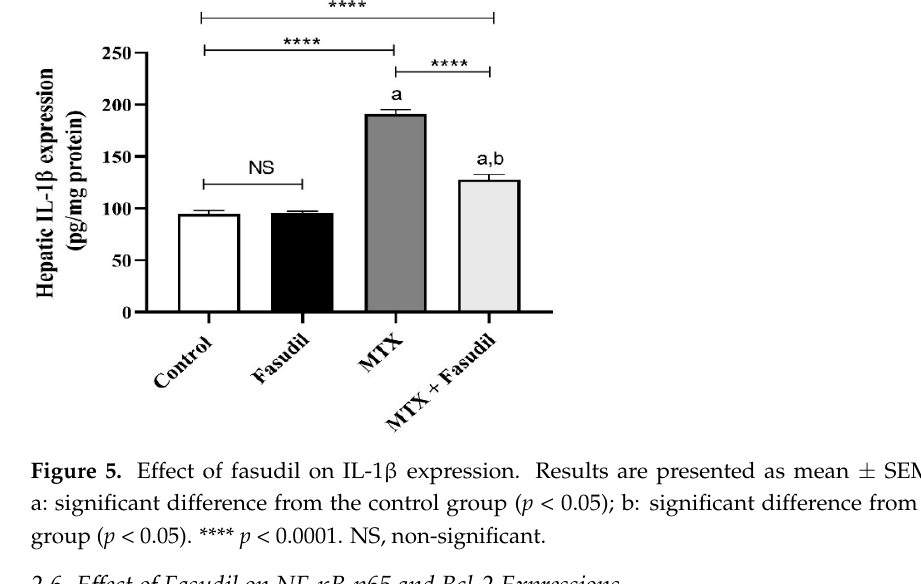
7 of 16 Figure 4. Effect of fasudil on the hepatic GSH content as well as antioxidant enzyme activity: ( A ) hepatic GSH content; ( B ) hepatic SOD activity; ( C ) hepatic catalase activity. Results are presented as mean ± SEM ( n = 8); a: significant difference from the control group ( p < 0.05); b: significant dif- ference from the MTX group ( p < 0.05). **** p < 0.0001. NS, non-significant. 2.5. Effect of Fasudil on IL-1 β Expression